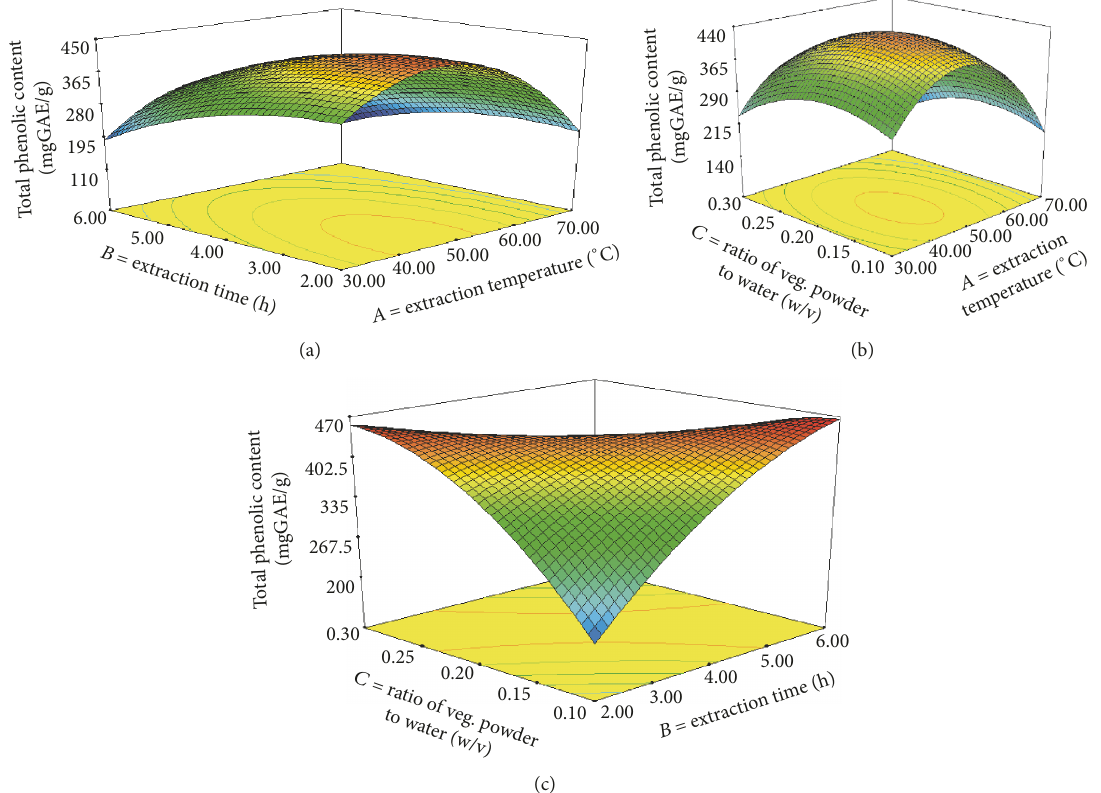
Figure 3: Interaction effects on the total polyphenol content of Solanum macrocarpon polyphenol concentrates: (a) extraction temperature and extraction time; (b) extraction temperature and vegetable powder : water ratio; (c) extraction time and vegetable powder: water